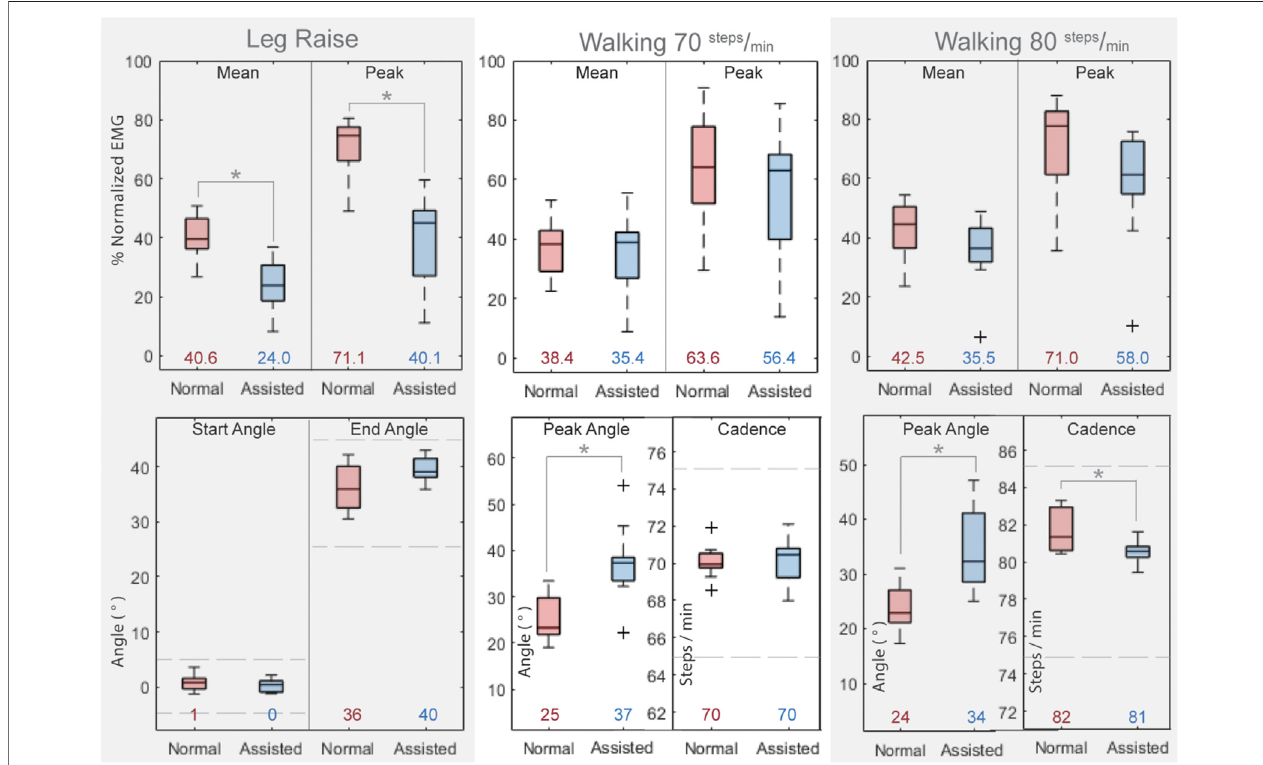
FIGURE 10 | Results of Human Subject Testing. Top Row: Normalized rectus femoris muscle activation values for all subjects for the three motions and two conditions. BottomRow: Kinematic attributes for three motions and two conditions. Asterisks indicate statistical signi fi cance.Horizontal bars in boxes show the median value and colored numbers below boxes show the mean value for each respective con fi guration. Dashed lines approximate kinematic limits described in section 2.3.1 . Data Analysis.